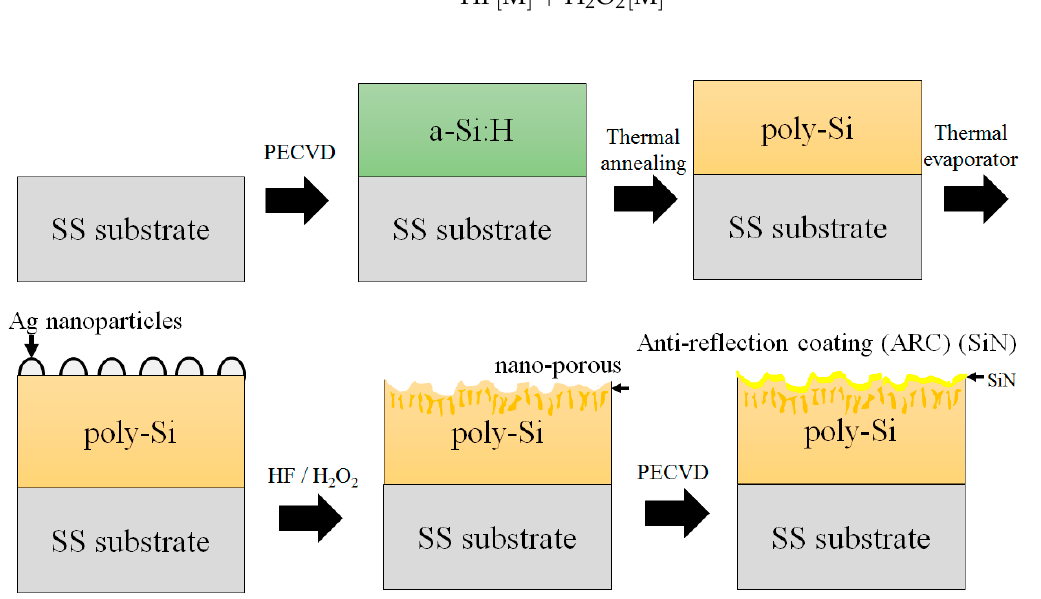
Figure 1. The fabrication process flow of the nano-porous poly-Si solar absorption films.